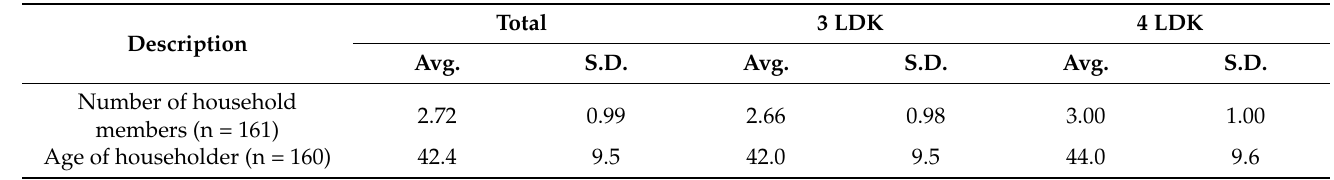
Table 4. Characteristics of household.